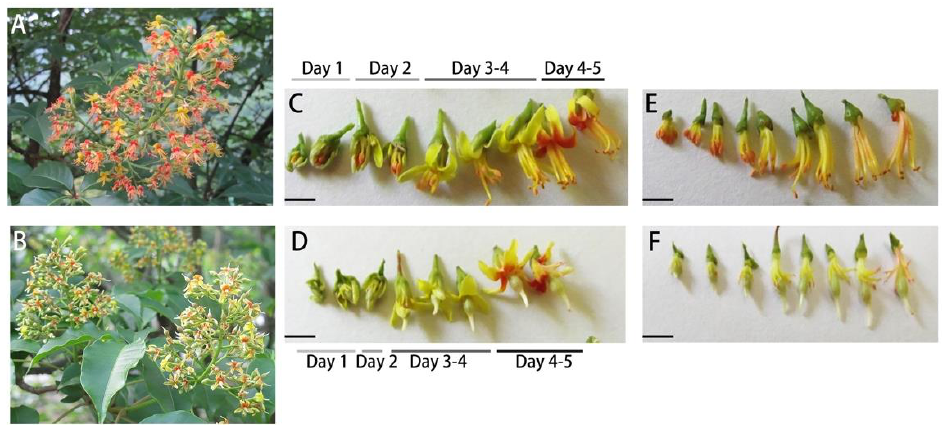
Figure 1. Phenotypic characterization of female and male flowers and floral buds. ( A , B ) The phenotype of male ( A ) and female ( B ) plants of H. bodinieri . ( C – F ) The phenotype of male ( C , E ) and female ( D , F ) floral buds of H. bodinieri , ( E – F ) only stamens and pistils remain. Scale bars indicate 5 mm in ( C – F ).